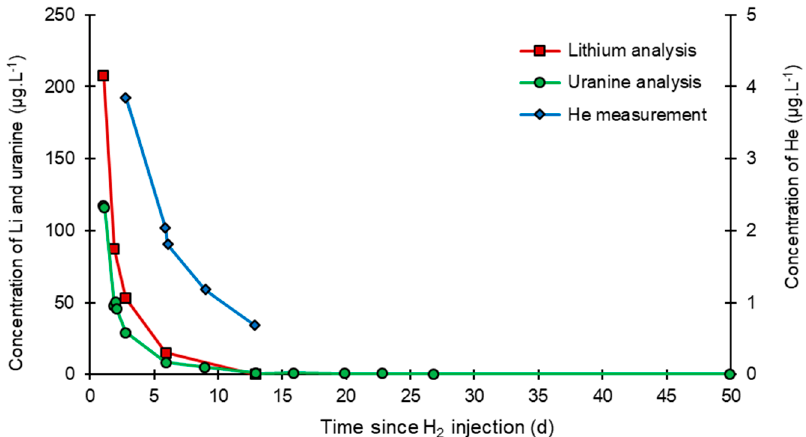
Figure 9. Evolution of the tracers at PZ2 (injection well).